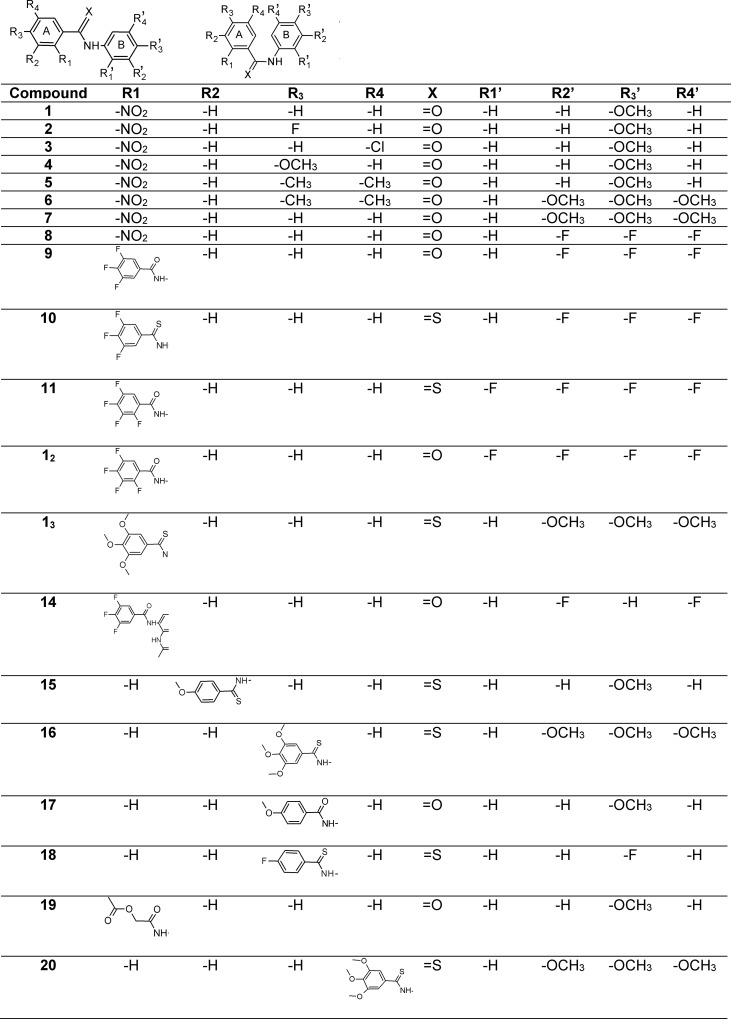
Structures of tested compounds, all compounds possess trans conformation except compounds 19 and 20.